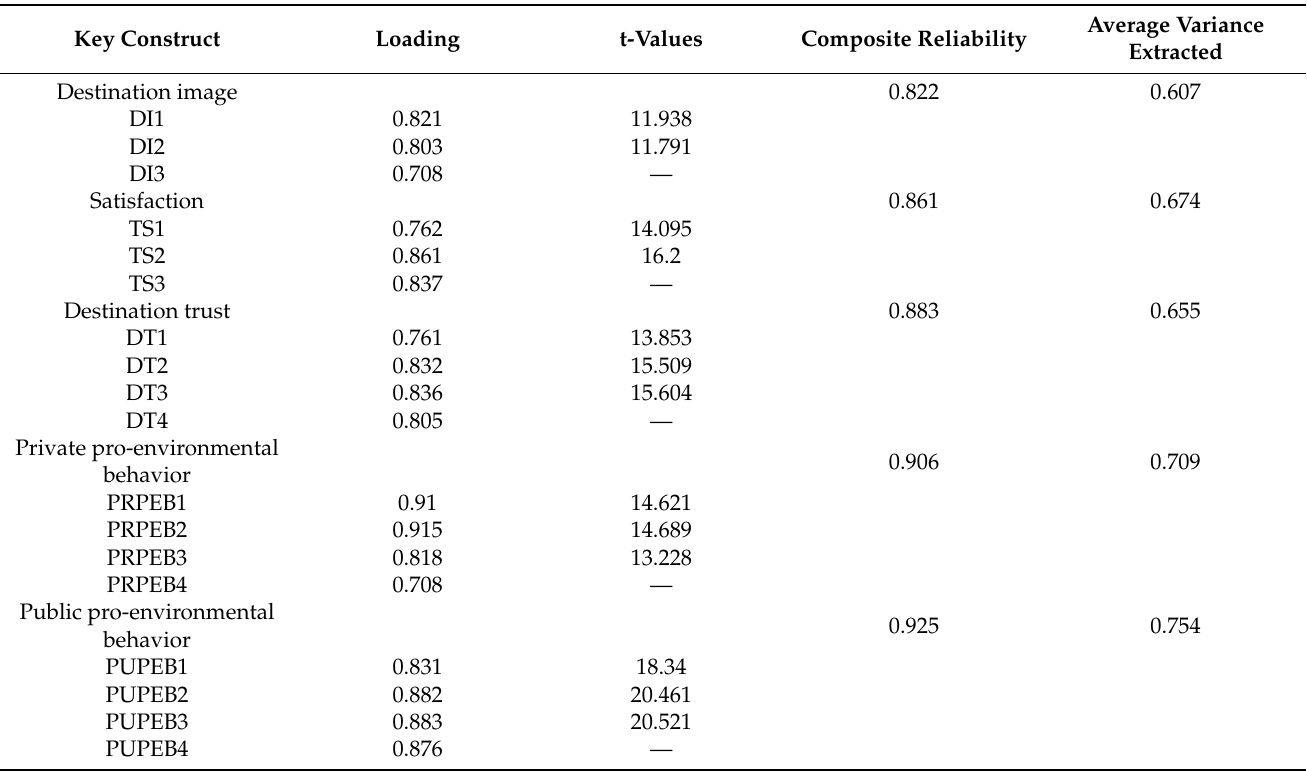
Table 2. Results of measurement